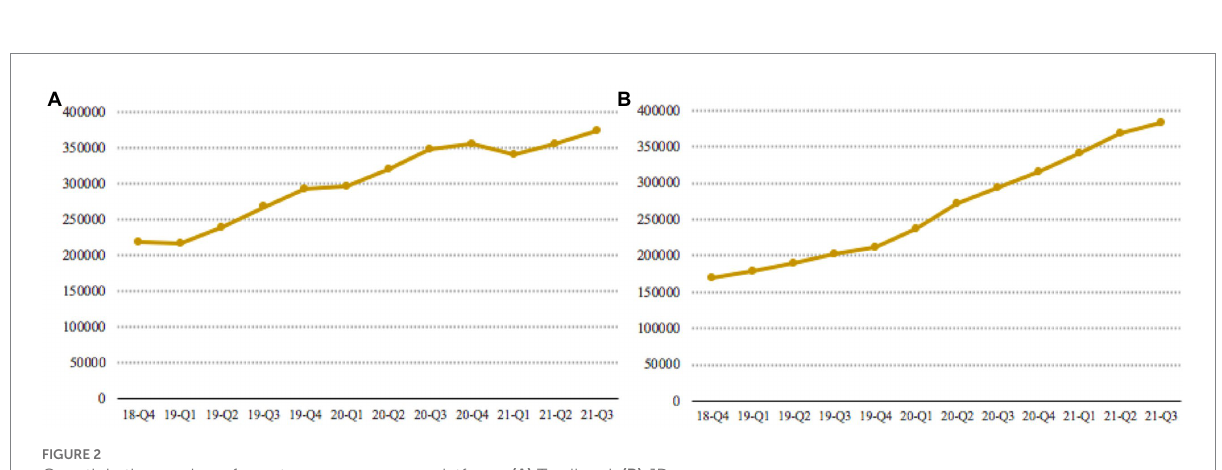
food and daily necessities, which are popular items in online shopping, also decreased significantly (as shown in Figures